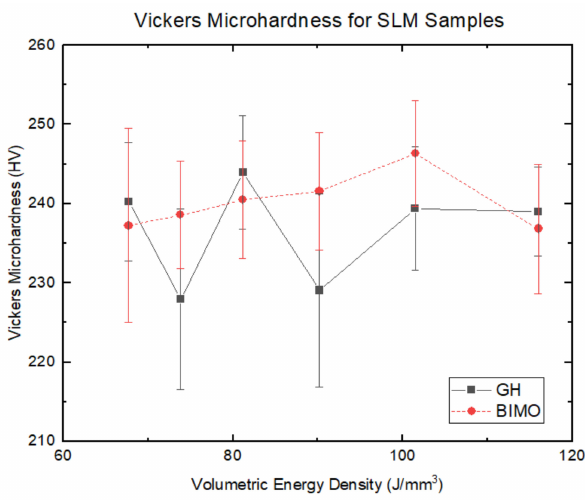
Figure 7. Vickers microhardness of SLM-manufactured samples produced from di ff erent powders at various VEDs in the highest power range (67.7–116.0 J / mm 3 at 203 W).